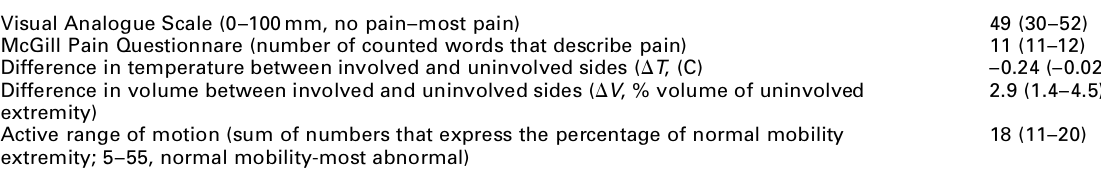
Table 2. Signs and symptoms of impairment Visual Analogue Scale (0–100mm, no pain–most